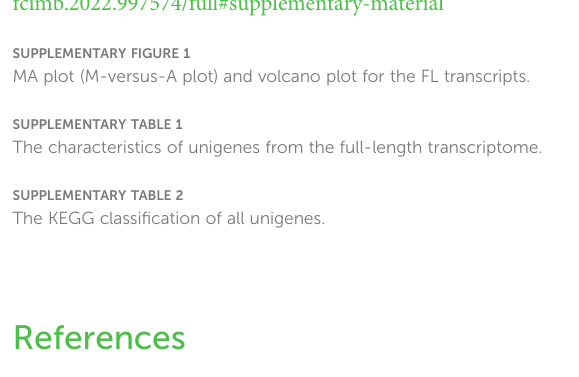
SUPPLEMENTARY TABLE 3 The KOG classi fi cation of all unigenes. SUPPLEMENTARY TABLE 4 Transcription factors analysis of all unigenes. SUPPLEMENTARY TABLE 5 miRNA-mRNA interaction analysis. SUPPLEMENTARY TABLE 6 LncRNA analysis of all unigenes.